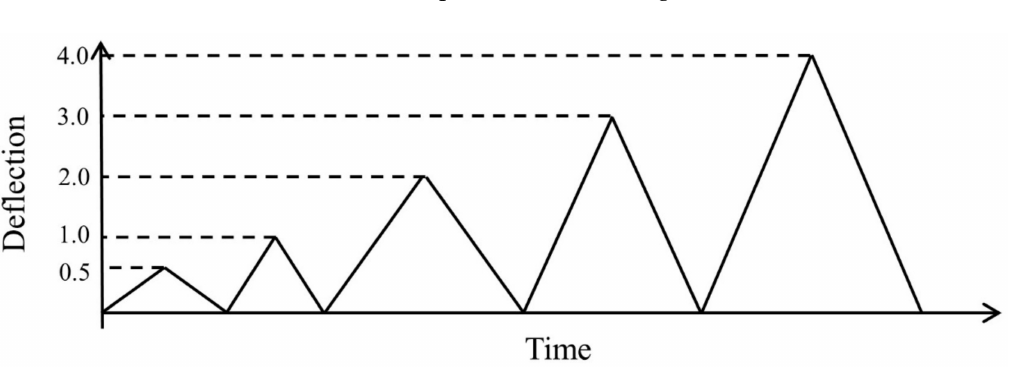
Figure 2. Schemed applied cyclic loading